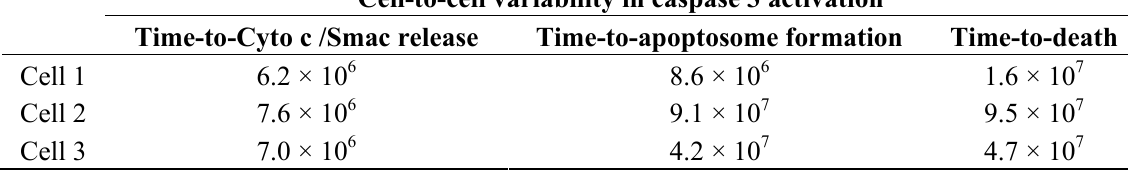
Table 3. Cell-to-cell stochastic variability in time-to-death (capsase 3 activation) results from cell-to-cell variability in (i) cytochrome c release (pre-mitochondrial signaling module) and (ii) apoptosome formation (post-mitochondrial signaling module). Time-to-Cytochrome c/Smac release is estimated from the initiation of XIAP-Smac complex formation.